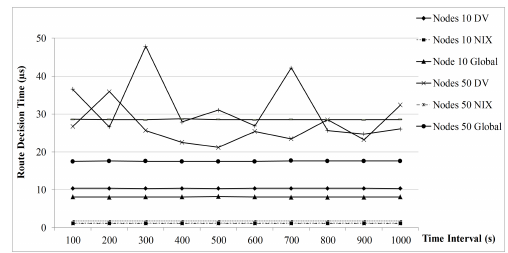
Figure 8: Route Decision Making Time (Avg.)